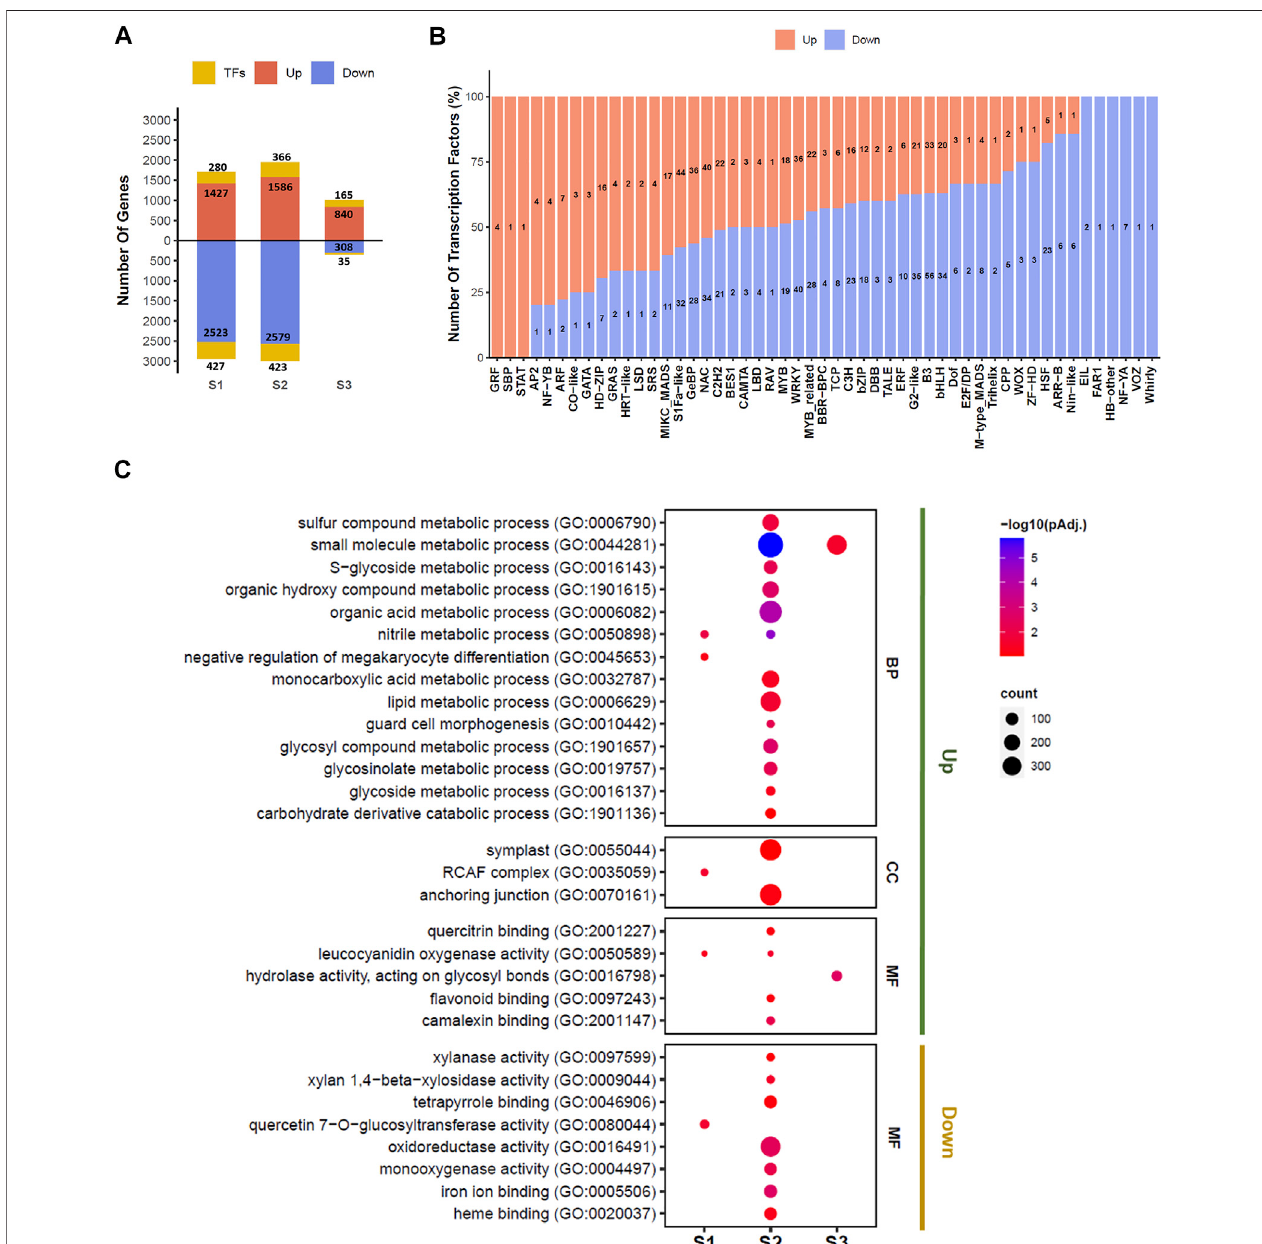
FIGURE2| DEGsatdifferentseeddevelopmentstagesbetweenEH-2andPJ. (A) BarplotdepictingthenumberofupregulatedanddownregulatedgenesinEH-2 vs. PJ at each developmental stage, and the number of differentially expressed TFs at each stage. (B) Barplot depicting the number of TFs belonging to different TF familiesshowingupregulationordownregulationinEH-2vs.PJ. (C) GOenrichmentofdifferentiallyexpressedgenesatdifferentseeddevelopmentstagesbetweenEH-2 and PJ. BP, biological process; CC, cellular component; MF, molecular function; E, EH-2; P, PJ; S1 – S3, seed development stages; DEGs, differentially expressed genes; TFs, transcription factors; GO, Gene